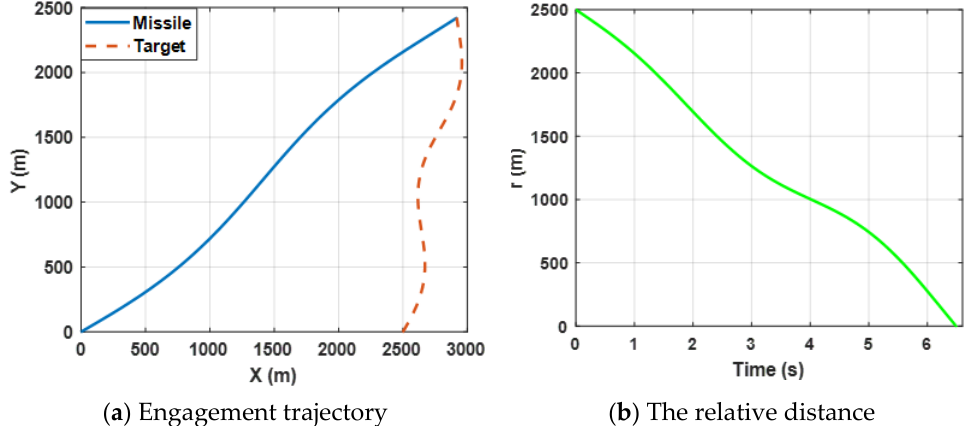
Figure 9. Engagement scenario for the target’s maneuverability.